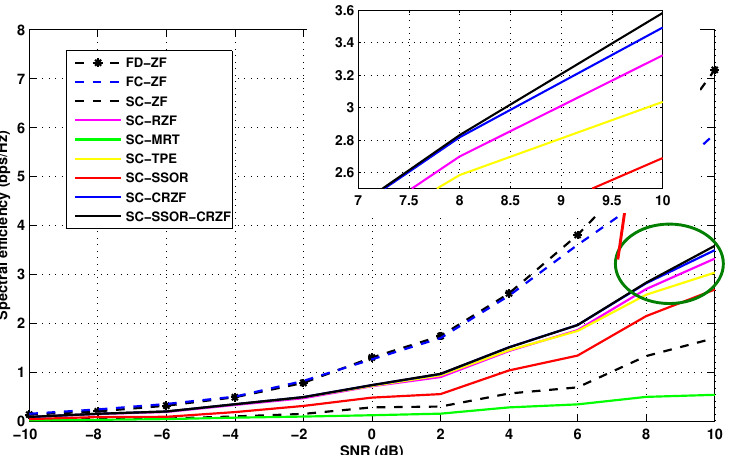
Figure 2. Spectral Efficiency